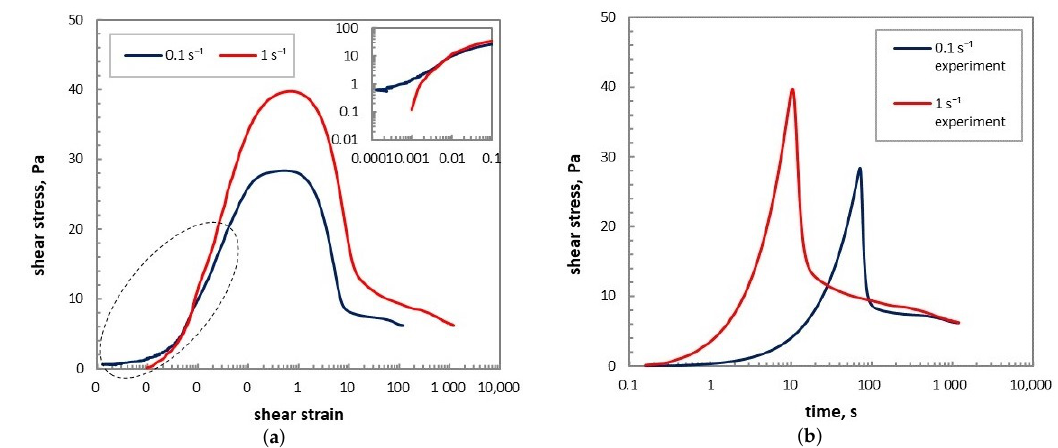
Figure 1. Experimental results of the evolution of shear stress during yielding of an initially gelled waxy crude oil: ( a ) as a function of shear strain; ( b ) as a function of time t. Data provided by Zhang